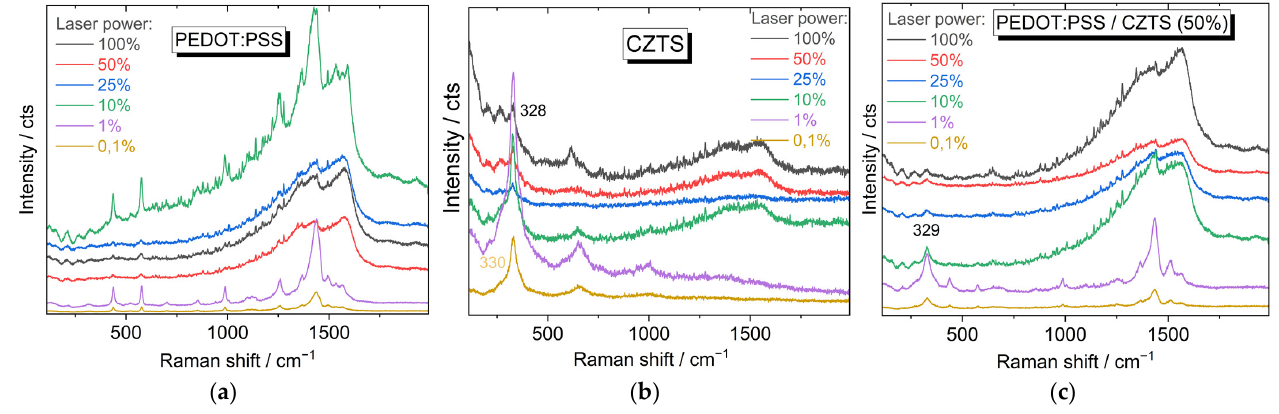
Figure 5. Raman spectra at different laser powers, as recorded for ( a ) PEDOT:PSS; ( b ) CZTS NCs; and ( c ) their composite.